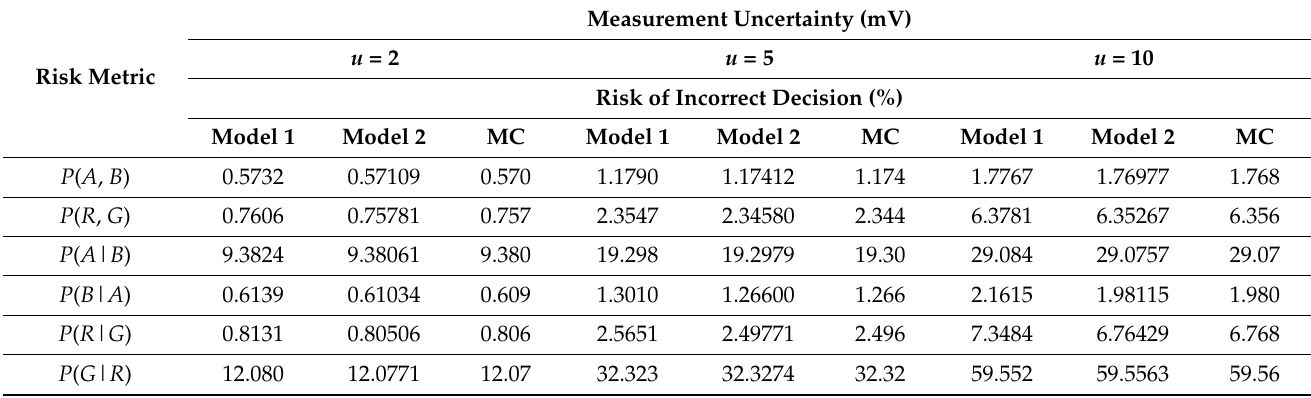
Table 4. Results of the risk analysis for Model 1, Model 2, and results of the MC simulation for the measurand with the Rayleigh distribution and the Gauss distribution characterizing the measuring system. Risk